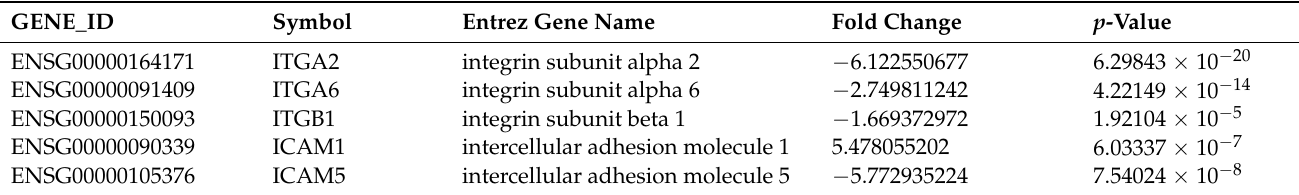
Table 5. Gene alteration associated with cell-matrix